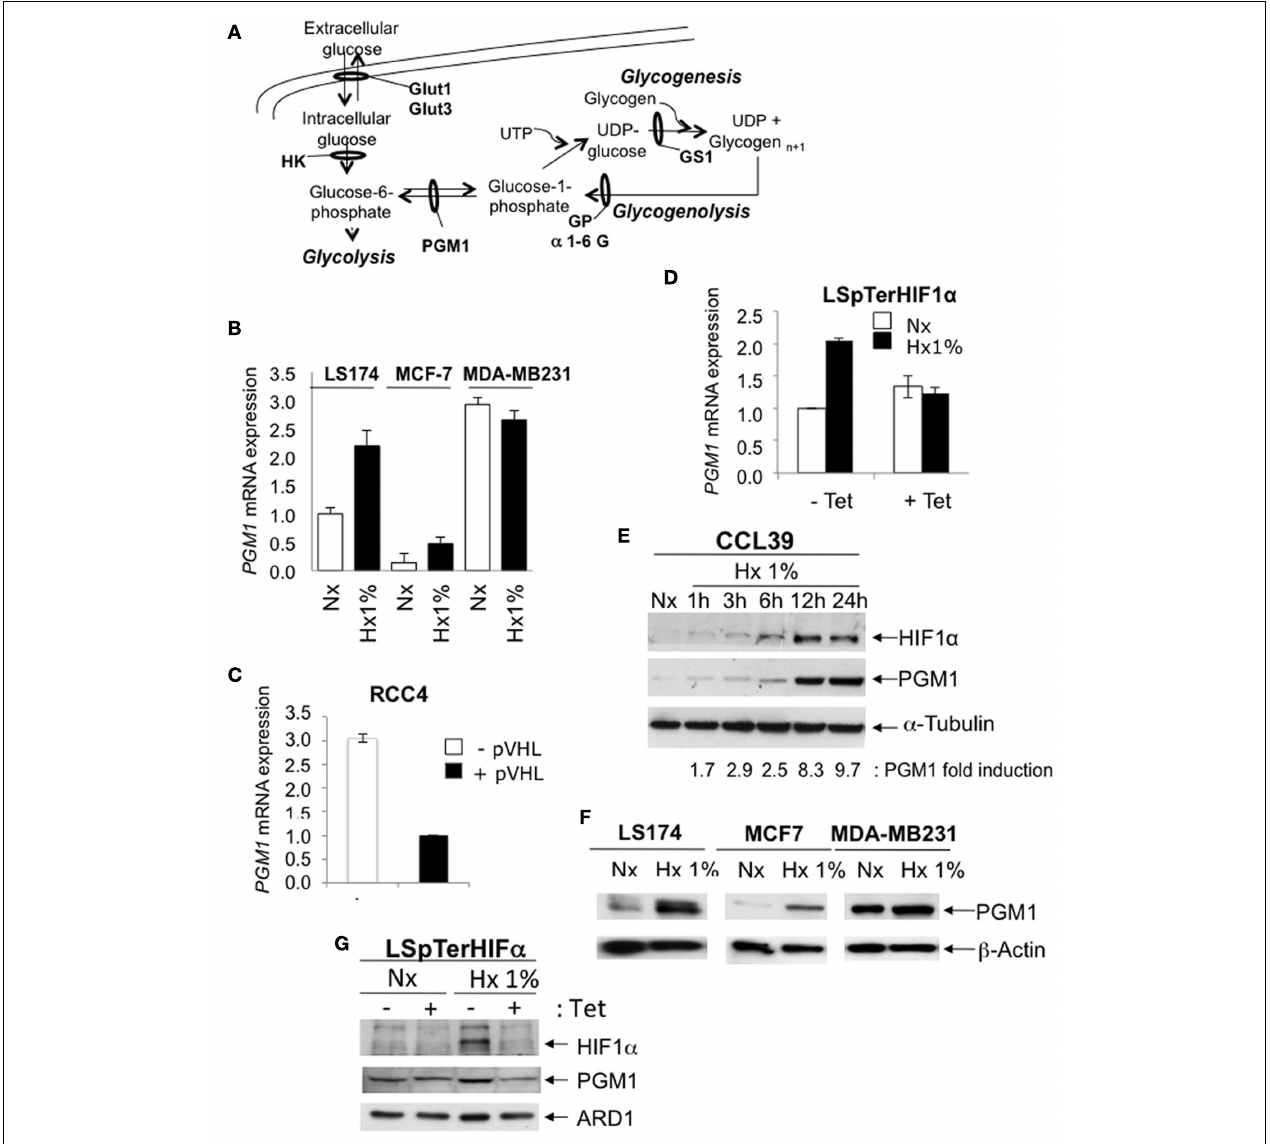
RCC4 (black bars) and 786-O cells (white bars) in the absence ( − ) or presence ( + ) of pVHL expression. Each difference in gene expression was estimated within the limits of a 95% confidence interval.The results are representative of at least two separate experiments. (D) Expression of the mRNA of PGM1 in LS174 pTerHIF α cells exposed to 48h of normoxia (Nx) or hypoxia 1% O 2 (Hx 1%) in the absence ( − ) or presence ( + ) ofTet (10 μ g/mL).The level of PGM1 mRNA was determined by real-time qPCR. Results are representative of at least two separate experiments with two different primers for PGM1 . (E) CCL39 cells were subjected to normoxia (Nx) or hypoxia 1% O 2 (Hx 1%) for 1, 3, 6, 12, and 24h.Total extracts were analyzed by immunoblotting with antibodies against HIF-1 α , PGM1, and α -tubulin. (F) LS174, MCF-7, and MDA-MB231 cells were subjected to normoxia (Nx) or hypoxia 1% O 2 (Hx 1%) for 48h.Total extracts were analyzed by immunoblotting with antibodies against PGM1 and β -Actin. (G) LS174 pTerHIF α cells were exposed for 24h to normoxia (Nx) or hypoxia 1% O 2 (Hx 1%) in the absence ( − ) or presence ( + ) ofTet (10 μ g/mL).Total extracts were analyzed by immunoblotting with antibodies against HIF-1 α , PGM1, and